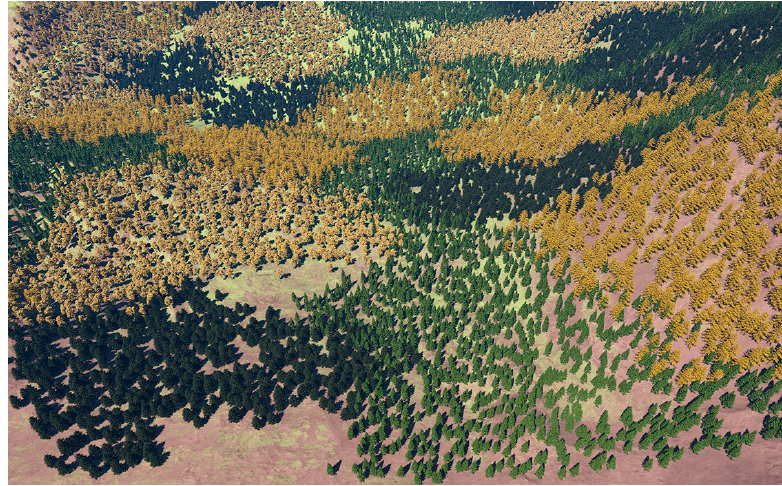
Figure 9. The rendering result of tree distributions based on Figure 8a.